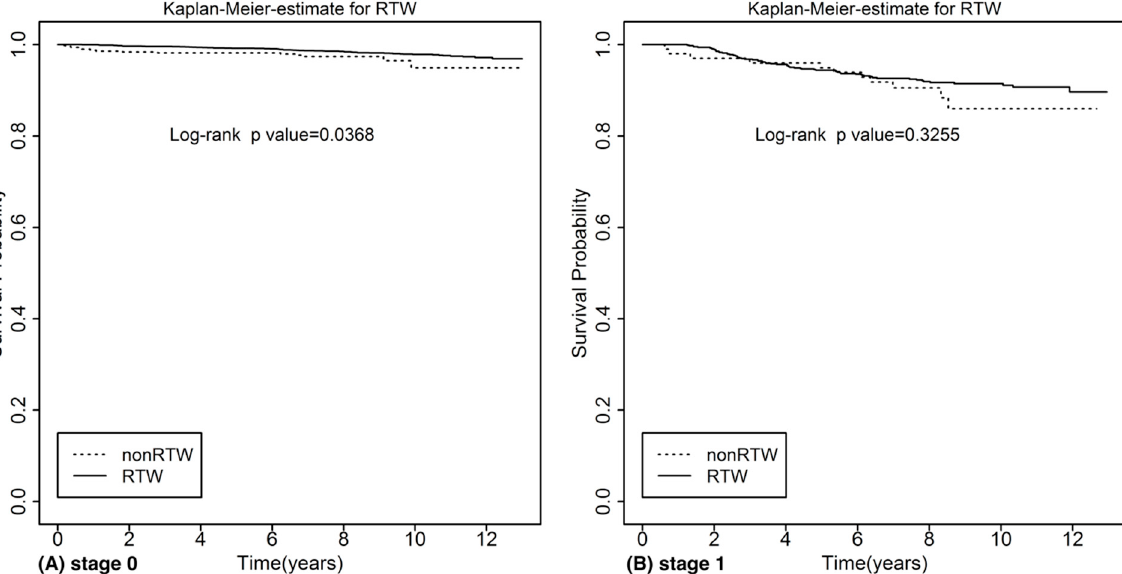
Figure 2. Kaplan-Meier curve for all-cause mortality categorized by different stages of cervical cancer. ( A ) Stage 0 of cer- vical cancer ( B ) Stage 1 of cervical cancer ( C ) Stage 2 of cervical cancer ( D ) Stage 3&4 of cervical cancer. Table 3. Multivariate analysis of association between independent variables and all-cause mortality of cervical cancer workers. Characteristic